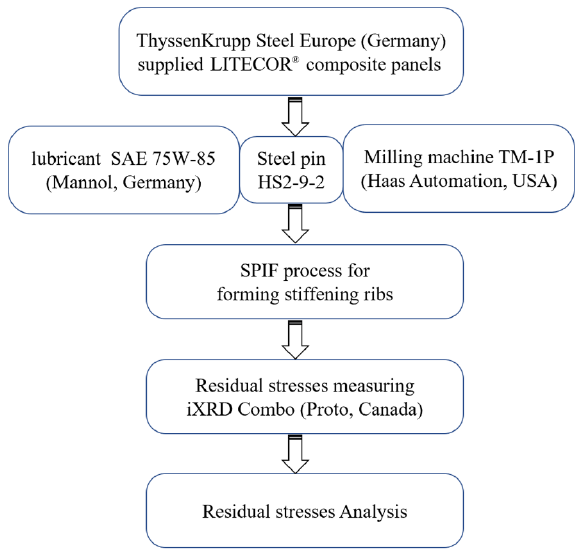
Figure 2. Flow chart of the experimental procedures.